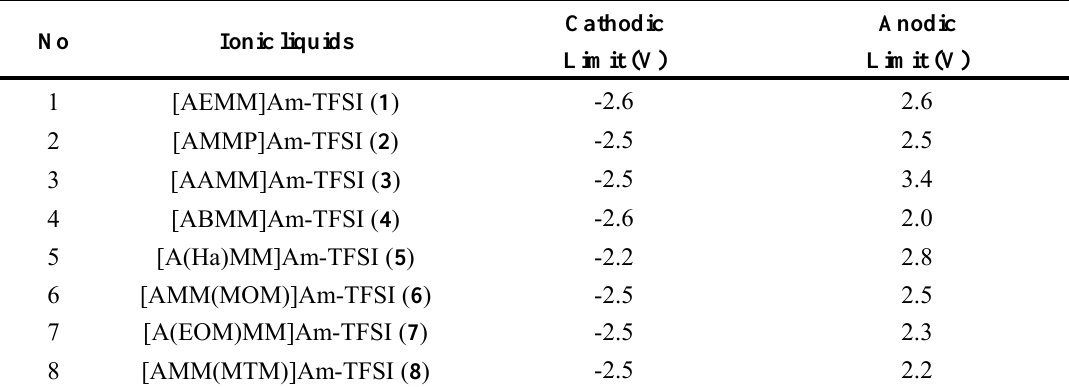
Table 2. Electrochemical windows of the ILs prepared a